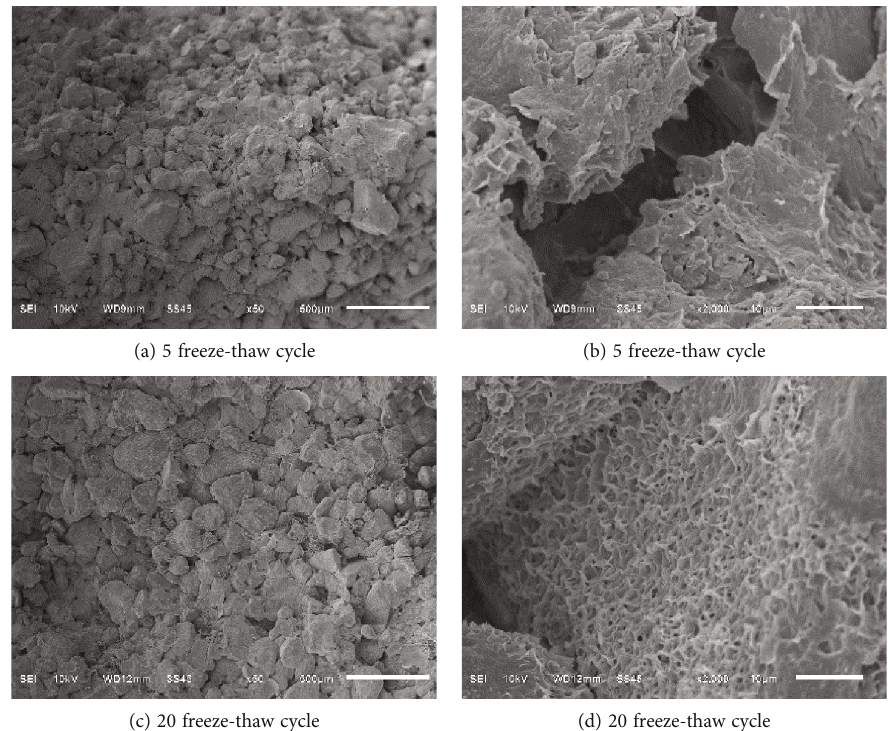
Figure 9: SEM images of red sandstone at di ff erent freeze-thaw times at 50 and 2000.